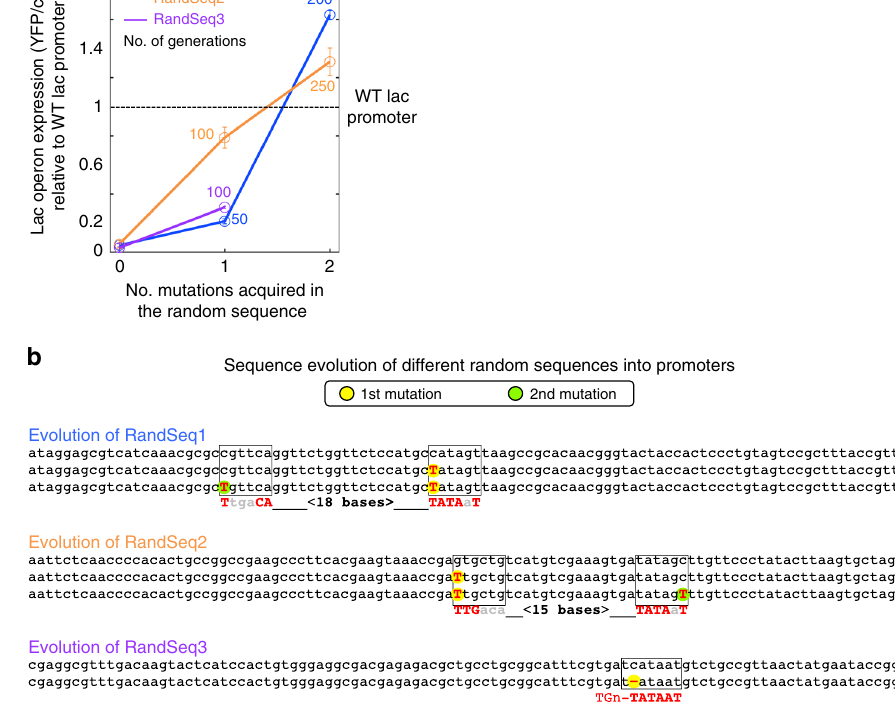
Fig. 2 From a random sequence to an active promoter by stepwise mutations (example from three random sequences). a Evolved expression levels of the lac genes are plotted for three strains that carry different random sequences (blue, orange, and purple) as a function of the number of acquired mutations. Expression level of 1 is de fi ned as the expression measured from the WT lac promoter, and 0 is de fi ned as the background read of the control strain, Δ LacOperon (in which the lac operon is deleted and no YFP gene was integrated). After the accumulation of mutations, de novo expression is observed (as well as the ability to utilize lactose). The number of generations is indicated near each mutation. Mutations shown were veri fi ed by reinsertion into their non-evolved ancestors. Error bars represent s.d. of YFP measurements of three biological replicates. b Sequences of the evolving promoters. For each strain, the top sequence is the random sequence before evolution, second, and third lines are the random sequence with the evolved mutations ( fi rst and second mutations, respectively). Increasing similarity to the canonical E. coli promoter motifs can be observed by different mutations. For each evolving promoter, the canonical promoter is shown as the bottom line where capital bases indicate a match. For RandSeq3, the evolved promoter is an extended − 10 promoter, thus the − 35 motif is not